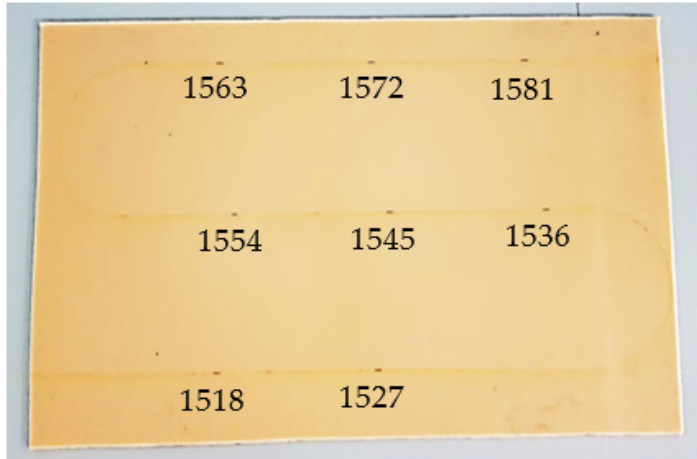
Figure 1. Fibre optic sensor with eight FBGs secured on the membrane. The center wavelength (in nm) of each sensor is shown.